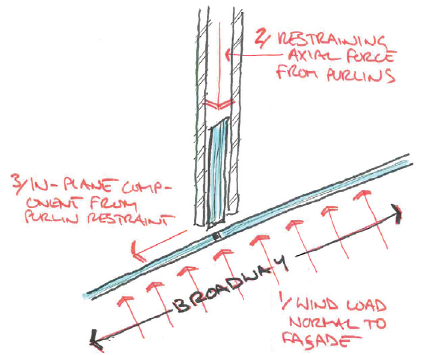
Figure 12: Typical bracing systems work assuming stiffening parallel to the direction of load. The 30 deg angle of the fins to the load direction results in in-plane force components within the façade